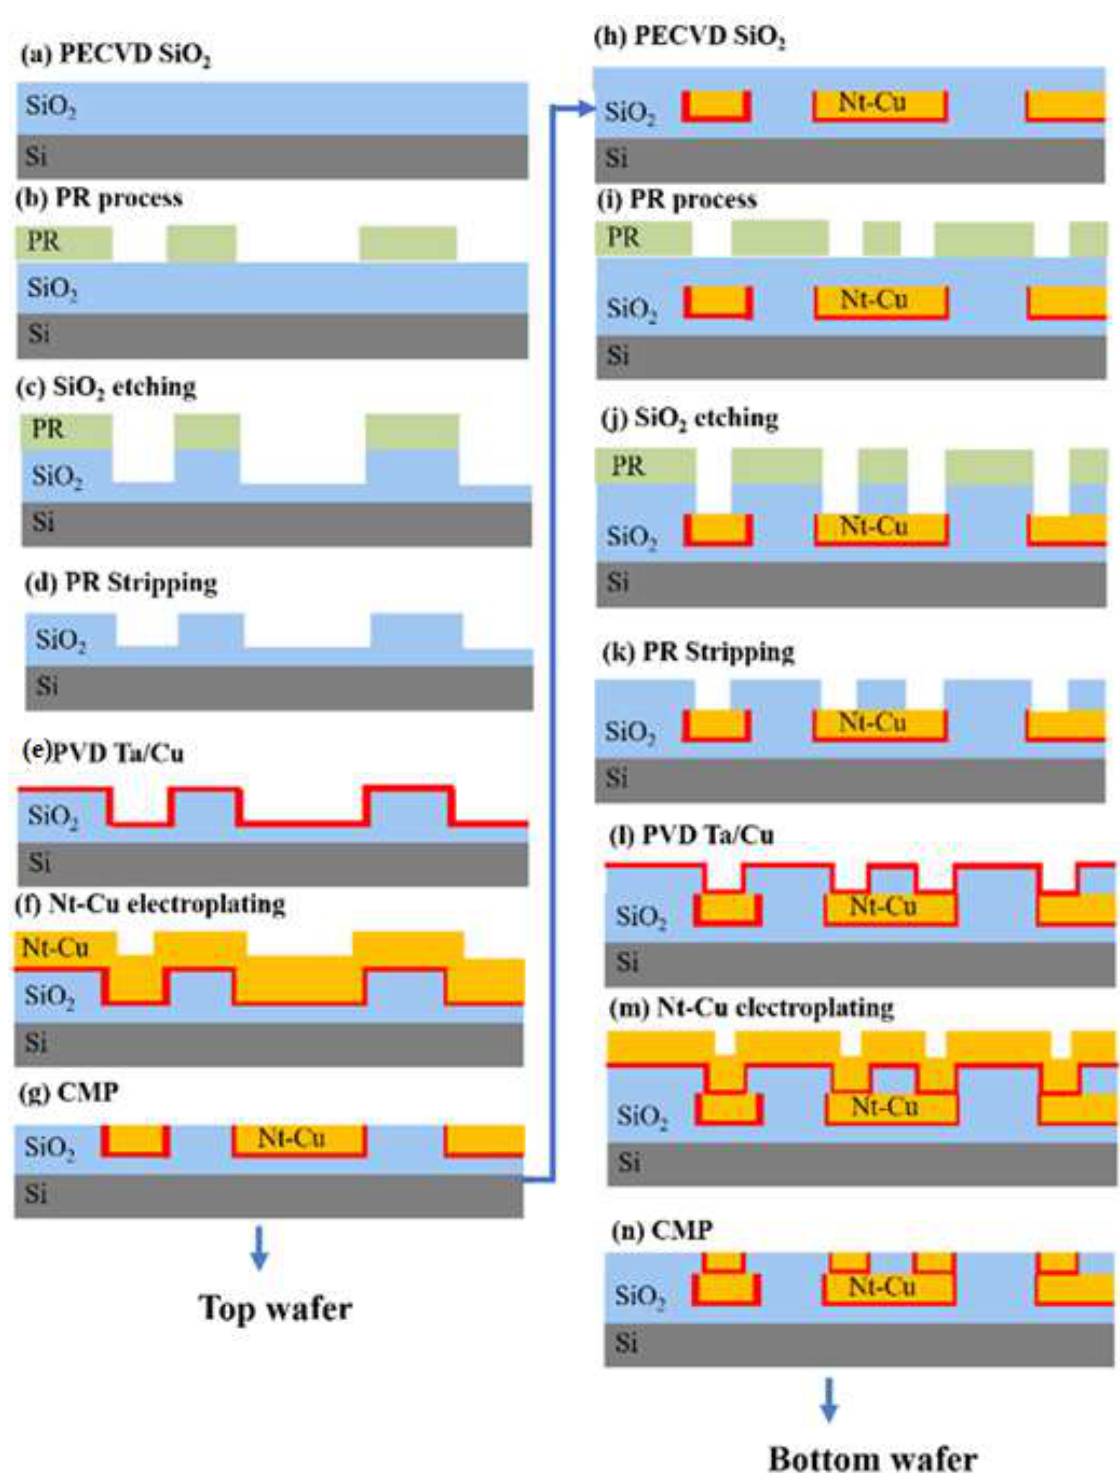
Figure 1. Schematic fabrication processes for top and bottom